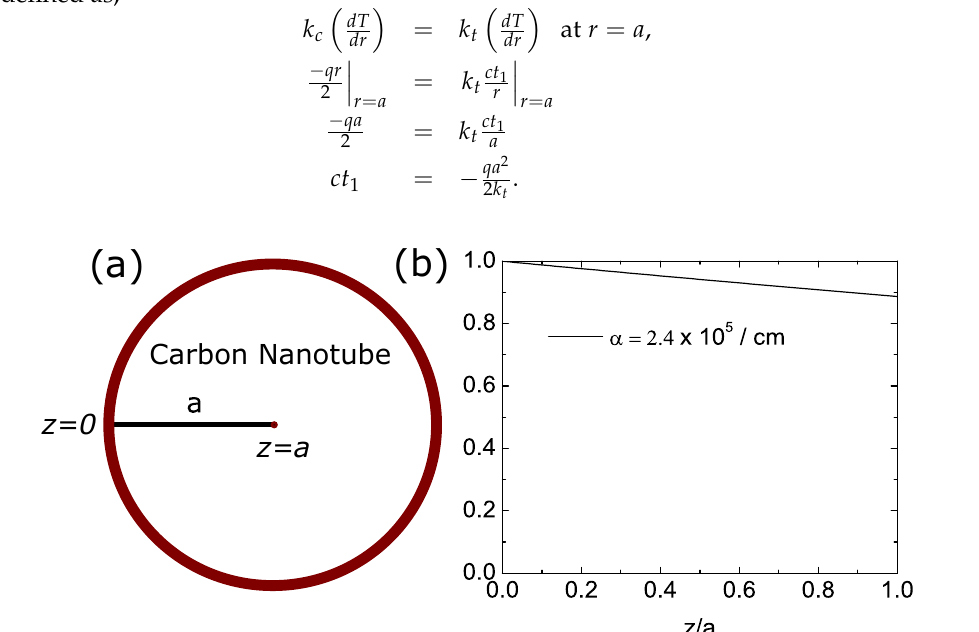
Figure 2. ( a ) The position of z = 0 and z = a in the model measured from the interface between CNT and cancer cells. ( b ) The exponential term in the heating function with the radius of CNT is 5 nm. We assume the heating function is constant to simplify the